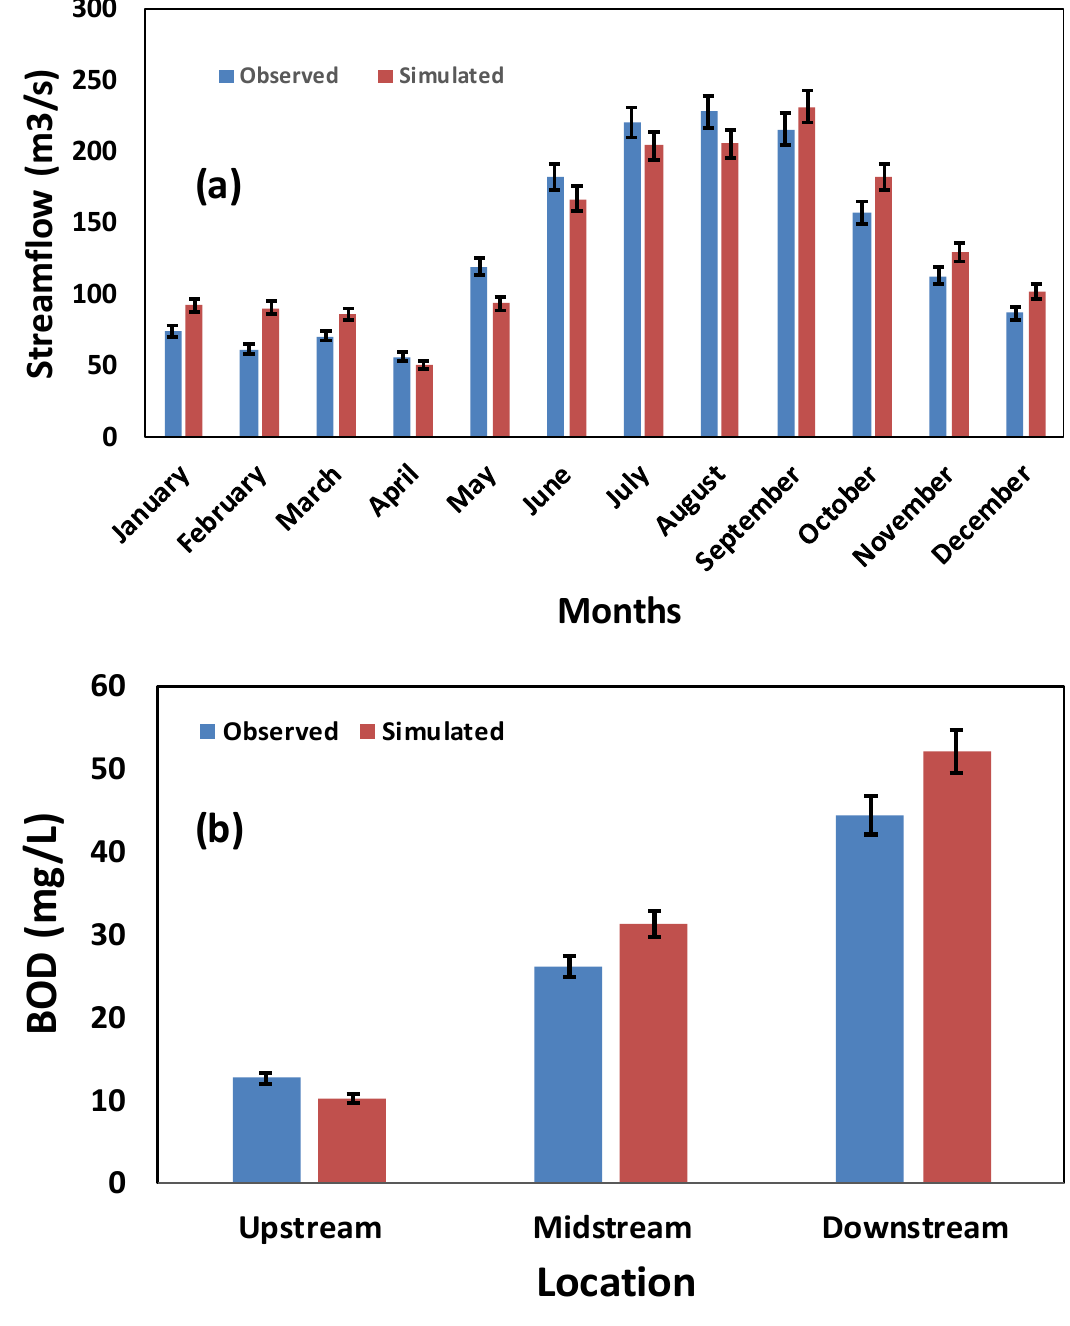
Figure 7. Validation of the model output by comparing simulated and observed ( a ) average monthly river discharge for year 2015 at Santa Rosa midstream; ( b ) average biochemical oxygen demand (BOD) values for different locations for the year 2014. Here small vertical black lines on the top of the bars are showing percentage error.